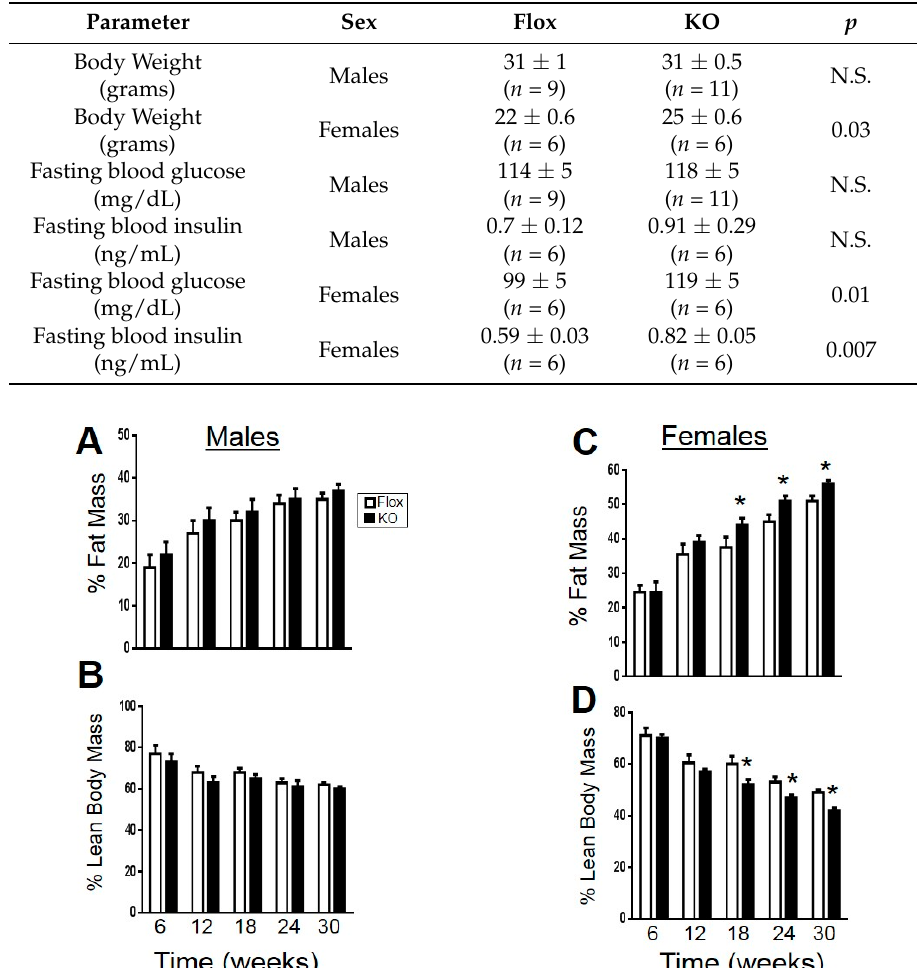
Figure 2. Fat and lean body mass in Flox and KO mice placed on a high-fat diet: ( A ) fat mass in males; ( B ) lean mass in males; ( C ) fat mass in females; and ( D ) lean mass in females. * p < 0.05 compared to corresponding value in Flox females. Flox males, n = 8, KO males, n = 7, WT and KO females, n = 6.